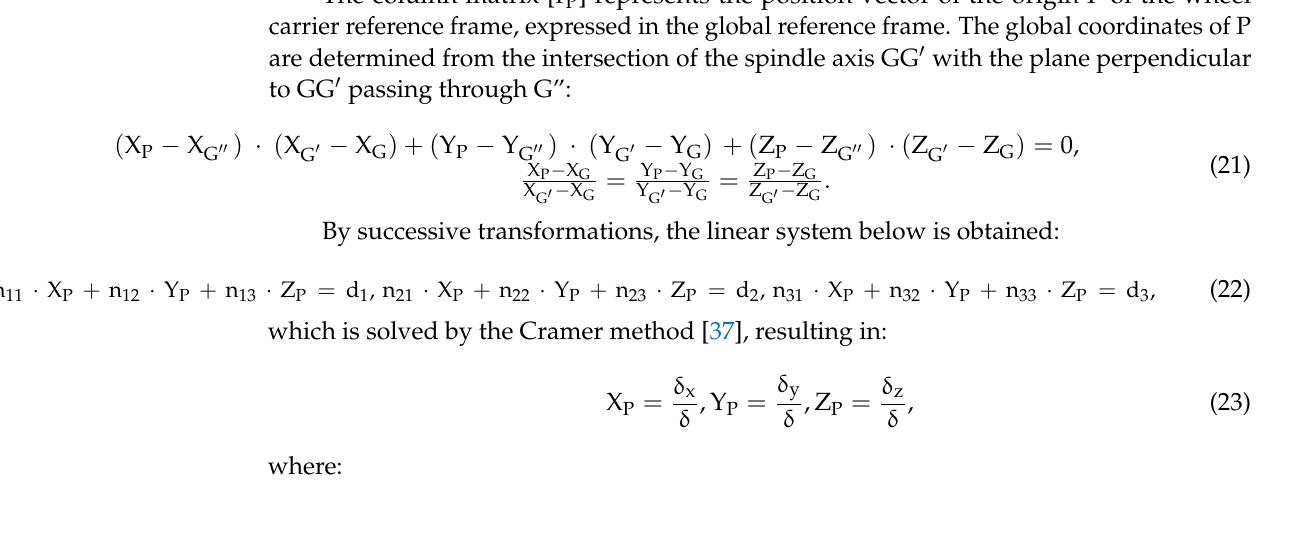
frame PX P Y P Z P has the origin P in the center of the spindle axis, along which the local transverse axis Y P is directed.